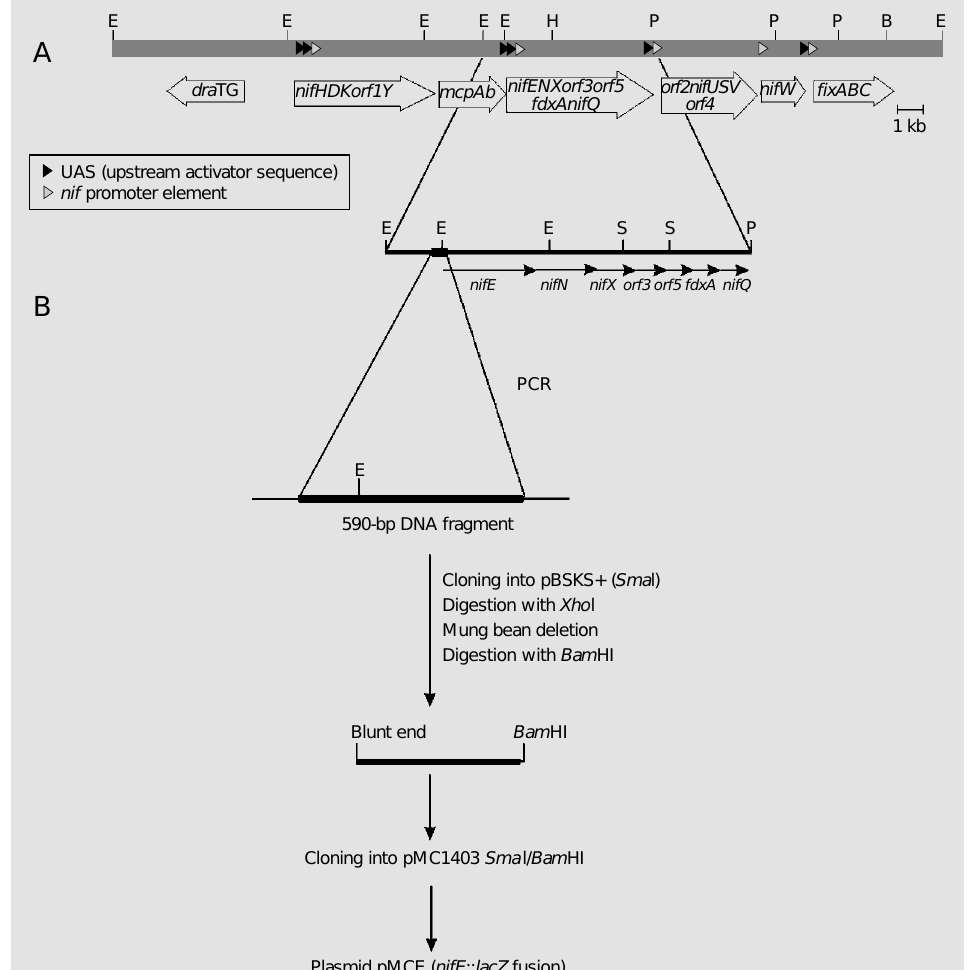
Figure 1. Physical map of the nif gene cluster in the genome of Azospirillum brasilense (A) and cloning strategy of the nifE pro- moter region (B). A , Represents the organization of nif and other genes in the chromosome of A. brasilense . Arrows represent the positions and direction of tran- scription of the operons. The nifENXorf3orf5fdxAnifQ operon is shown in detail in the lower part of the figure. Each restric- tion fragment was cloned into the pUC18 plasmid, as described in Table 1. B , Cloning strategy of the nifE promoter region into the pMC1403 plasmid. E, Eco RI; H, Hin dIII; P, Pst I; B, Bam HI; S, Sal